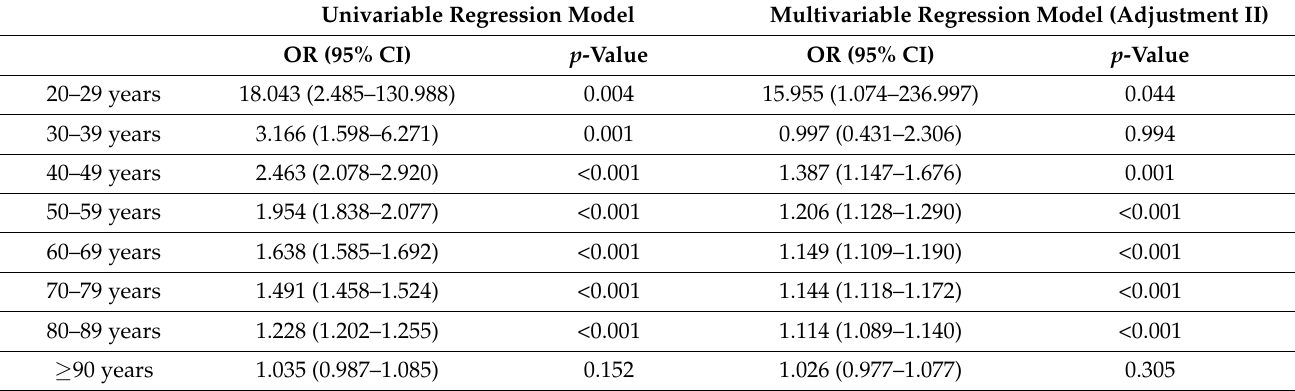
Table 4. Impact of diabetes mellitus on MACCE in PAD patients (univariable and multivariable logistic regression models).